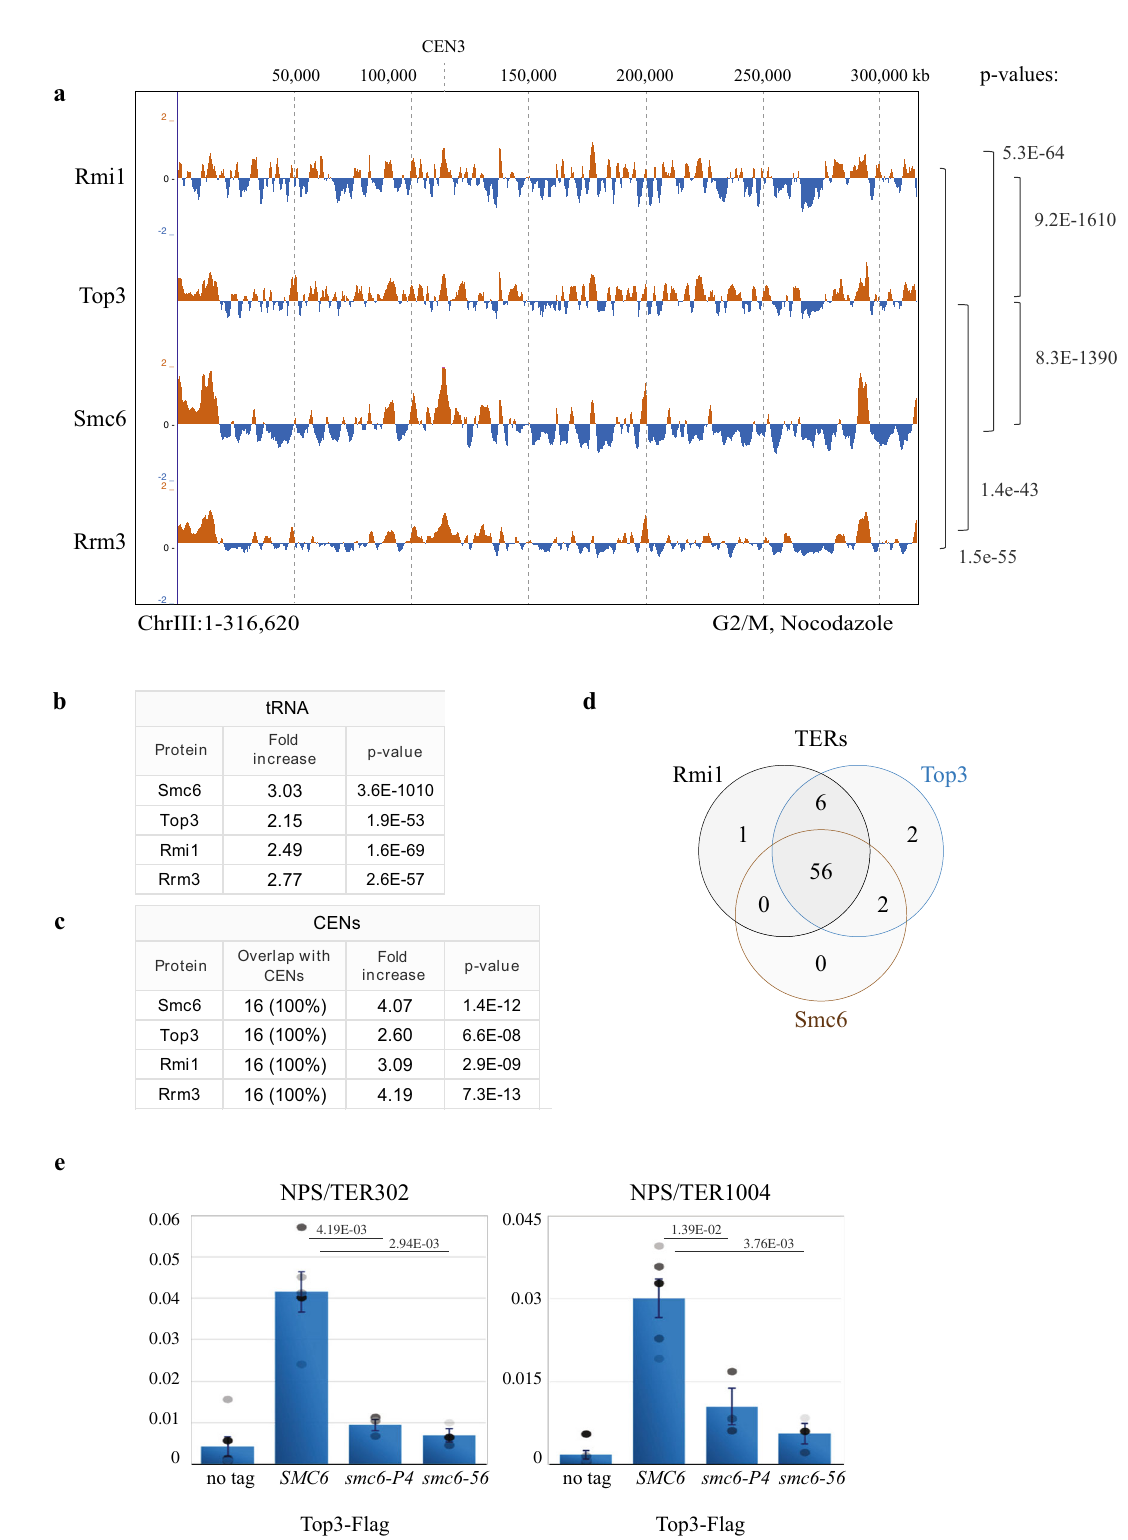
(Supplementary Fig. 2b, c), as previously reported for Smc5/6 16,42 . Thus, Smc5/6 colocalizes with STR genome-wide and facilitates local retention of Top3 at